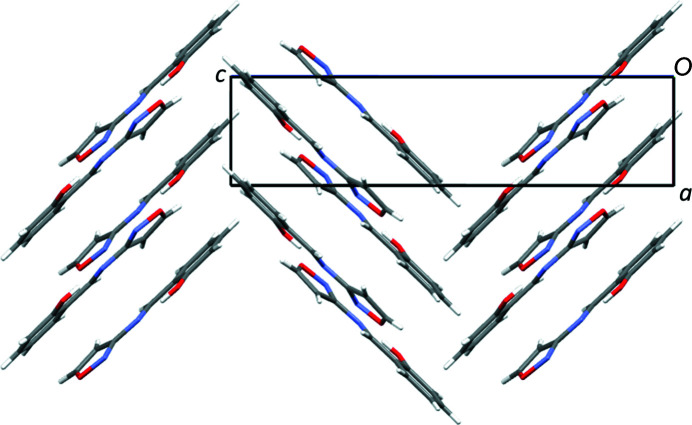
Illustration of the packing in 1, looking down the b axis.